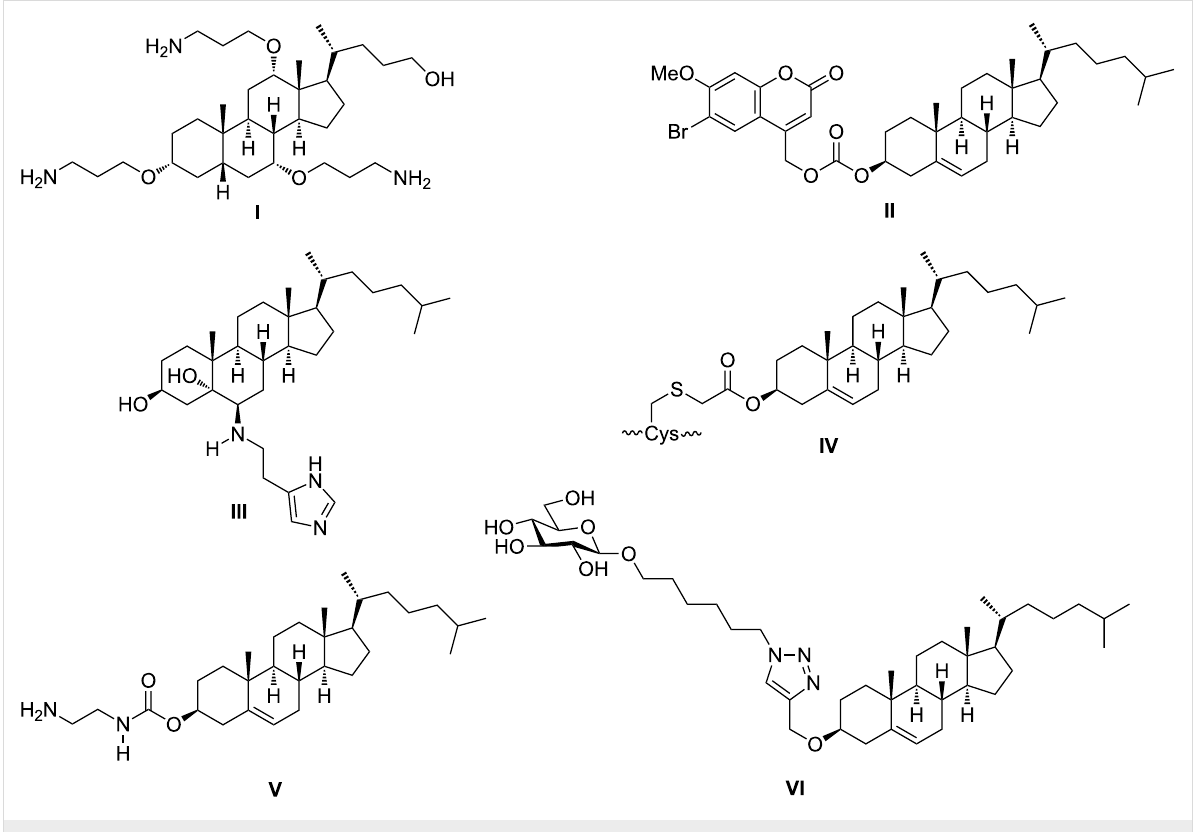
Figure 1: Structure of ceragenin (CSA-8) and selected cholesterol